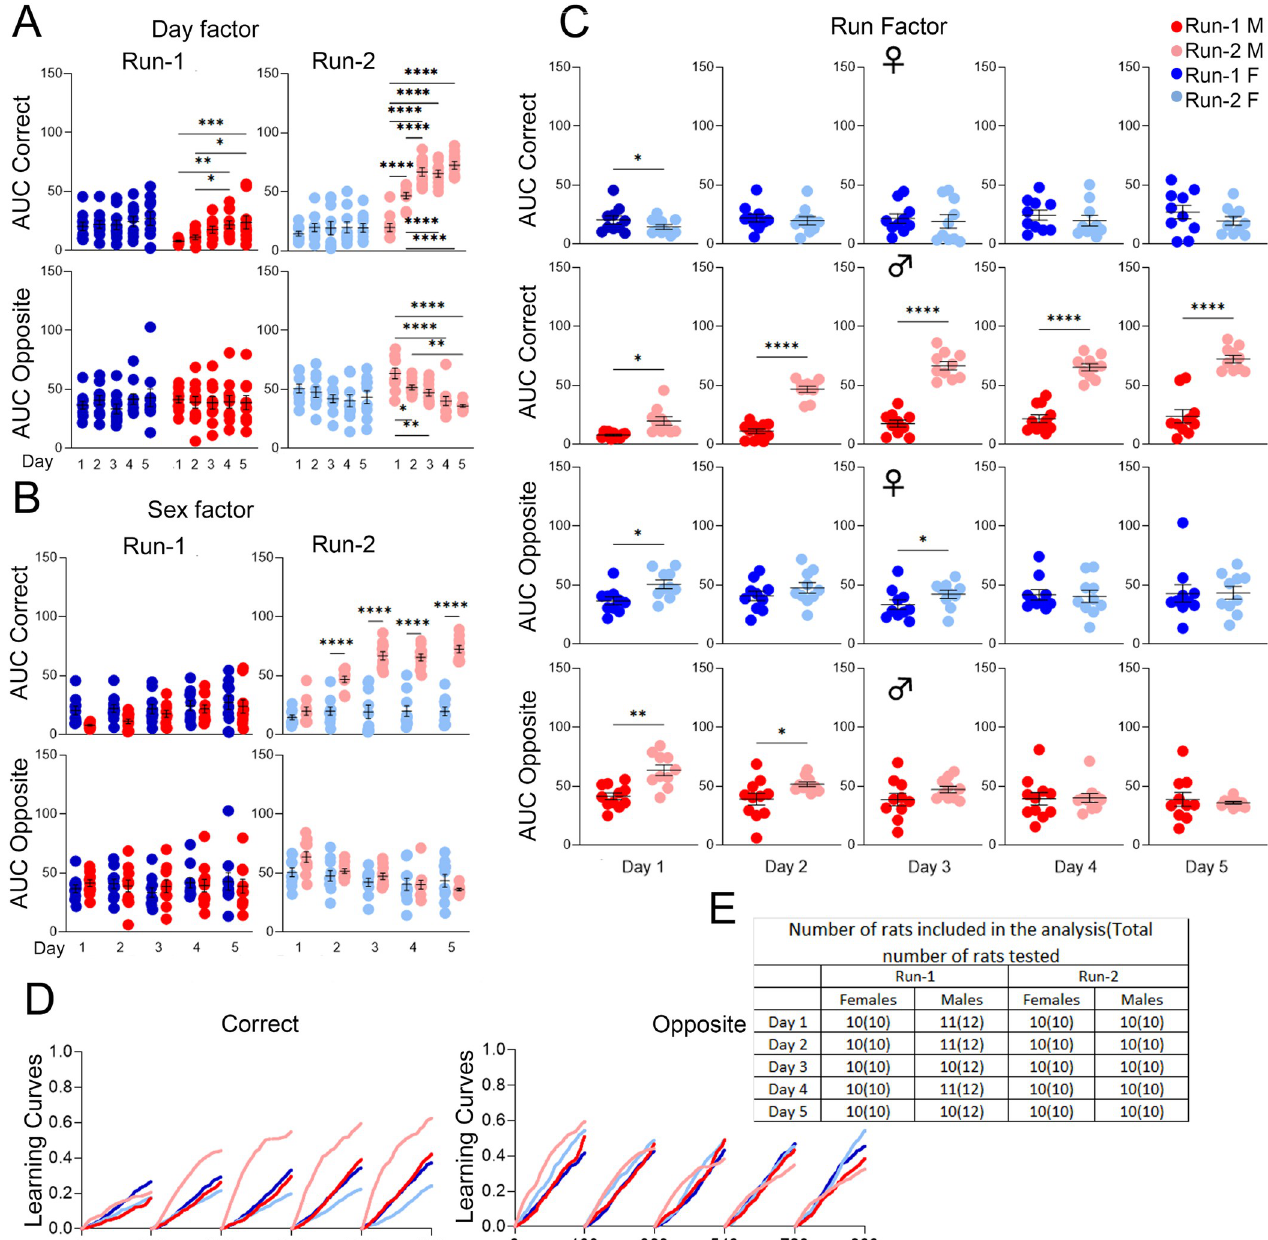
Fig 8. Behavioral sequencing, cohort B. (A) Day factor, (B) Sex factor and (C) Run factor comparisons of area under the curve (AUC) for activity curves of individual animals by sex, program day, and Run, separated by visit categories (Correct, BS-C or Opposite, BS-O). (D) Activity curves showing the fractional accumulation (y-axis) of correct visits or opposite visits over drinking session time (x-axis), reset every 180 minutes, by sex and Run. (E) For Run-1, 12 male and 10 female rats were tested since 2 females died just before the timeline started. One male was excluded from the analysis of days 1, 2, and 4, while two males were excluded from the analysis of days 3 and 5 during Run-2. These animals were excluded because they visited corners less than 25 times during those drinking sessions. For Run-2, 10 male and 10 female rats were tested, since one male died during the time between Runs, and one male died after place learning with corner switch. All 20 rats were included in the analysis of Run-2. All data represented as mean ± SEM ( � p < 0.05, �� p < 0.01, ��� p < 0.001, ���� p < 0.0001). See Tables 12 and 13 for statistical analysis. Males (M or ♂ ) are colored as red (Run-1) and light red (Run-2). Females (F or ♀ ) are colored as blue (Run-1) or light blue (Run-2).